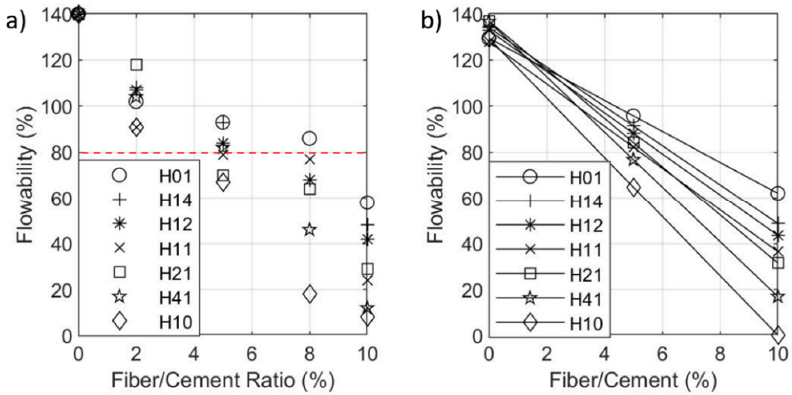
Figure 6. ( a ) Flowability of different fiber/cement ratios and fiber mixing ratios, and ( b ) linear regression for flowability at different mixing ratios with fiber content.